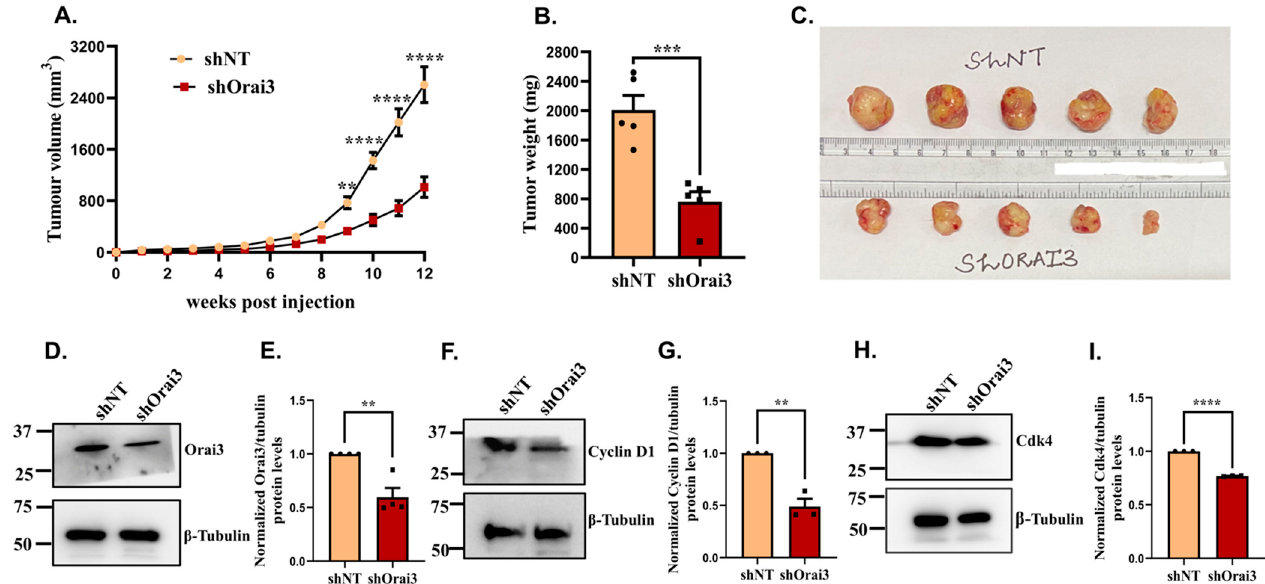
Figure 8. Orai3 regulates pancreatic cancer progression in vivo. ( A ) Weekly tumor volume measurements in NOD SCID mice injected with either shNT Panc1 cells or shOrai3 Panc1 cells ( n = 5 mice/condition). ( B ). Tumor weight measurements after sacrificing mice at 12-week post-injections (either shNT Panc1 or shOrai3 Panc1 injections) timepoint. ( C ). Pictures of shNT and shOrai3 Panc1 tumors harvested after 12 weeks of injections. ( D ). Western blot analysis for Orai3 expression in shNT Panc1 and shOrai3 Panc1 tumors. ( E ). Densitometric analysis of validating Orai3 knockdown in shOrai3 Panc1 tumors in comparison to shNT Panc1 tumors. ( F ). Western blot analysis for cyclin D1 levels in shNT Panc1 and shOrai3 Panc1 tumors. ( G ). Densitometric analysis of cyclin D1 levels in shNT Panc1 and shOrai3 Panc1 tumors. ( H ). Western blot analysis for Cdk4 expression in shNT Panc1 and shOrai3 Panc1 tumors. ( I ) Densitometric analysis of Cdk4 levels in shNT Panc1 and shOrai3 Panc1 tumors. Data presented as mean ± S.E.M. Unpaired Student’s t -test was performed for statistical analysis except from tumor volume wherein two-way ANOVA was performed. p -value < 0.01 is denoted as “**”; p -value < 0.001 is presented as “***” and p -value < 0.0001 is denoted as “****”.